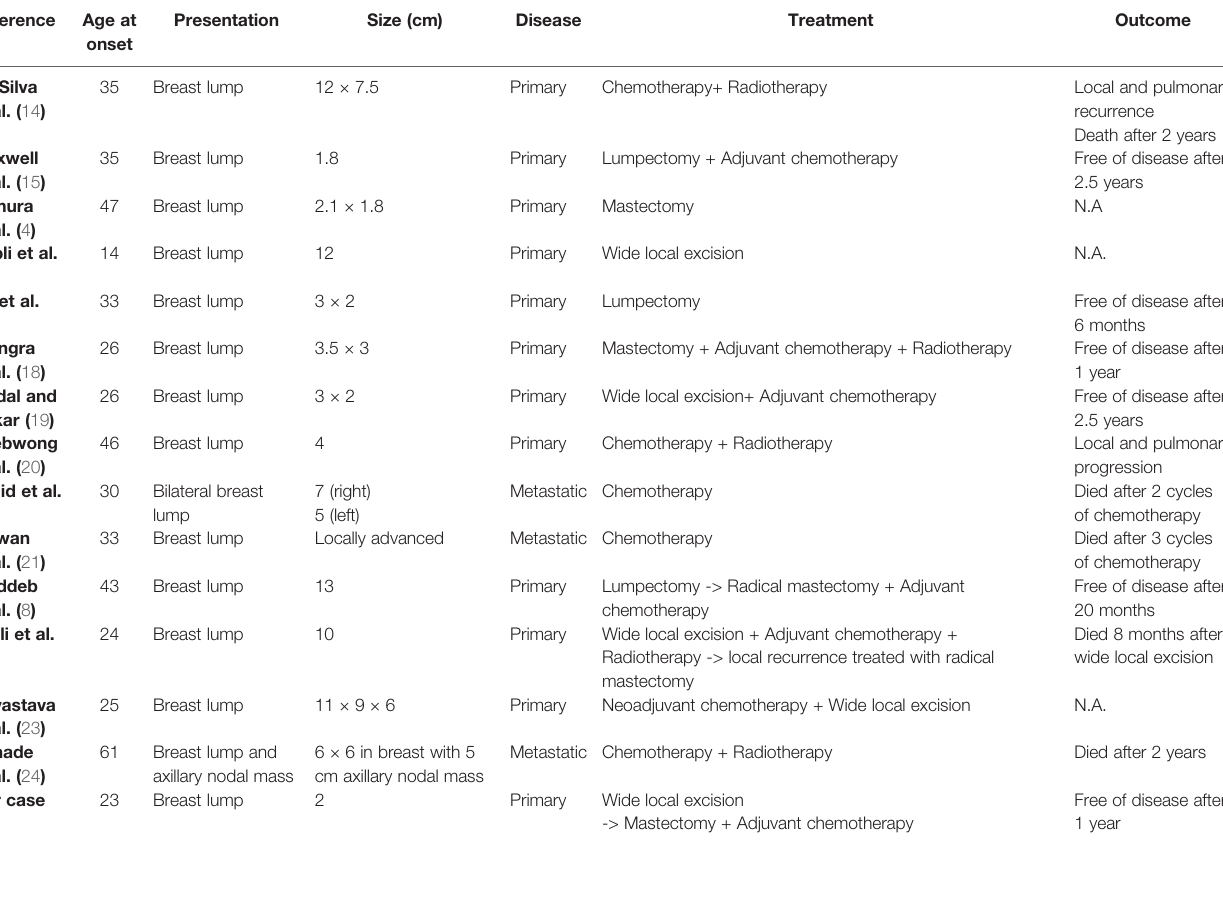
TABLE 1 | Clinical features and therapeutic course of primary and metastatic Ewing's sarcomas/pPNETpreviously published.